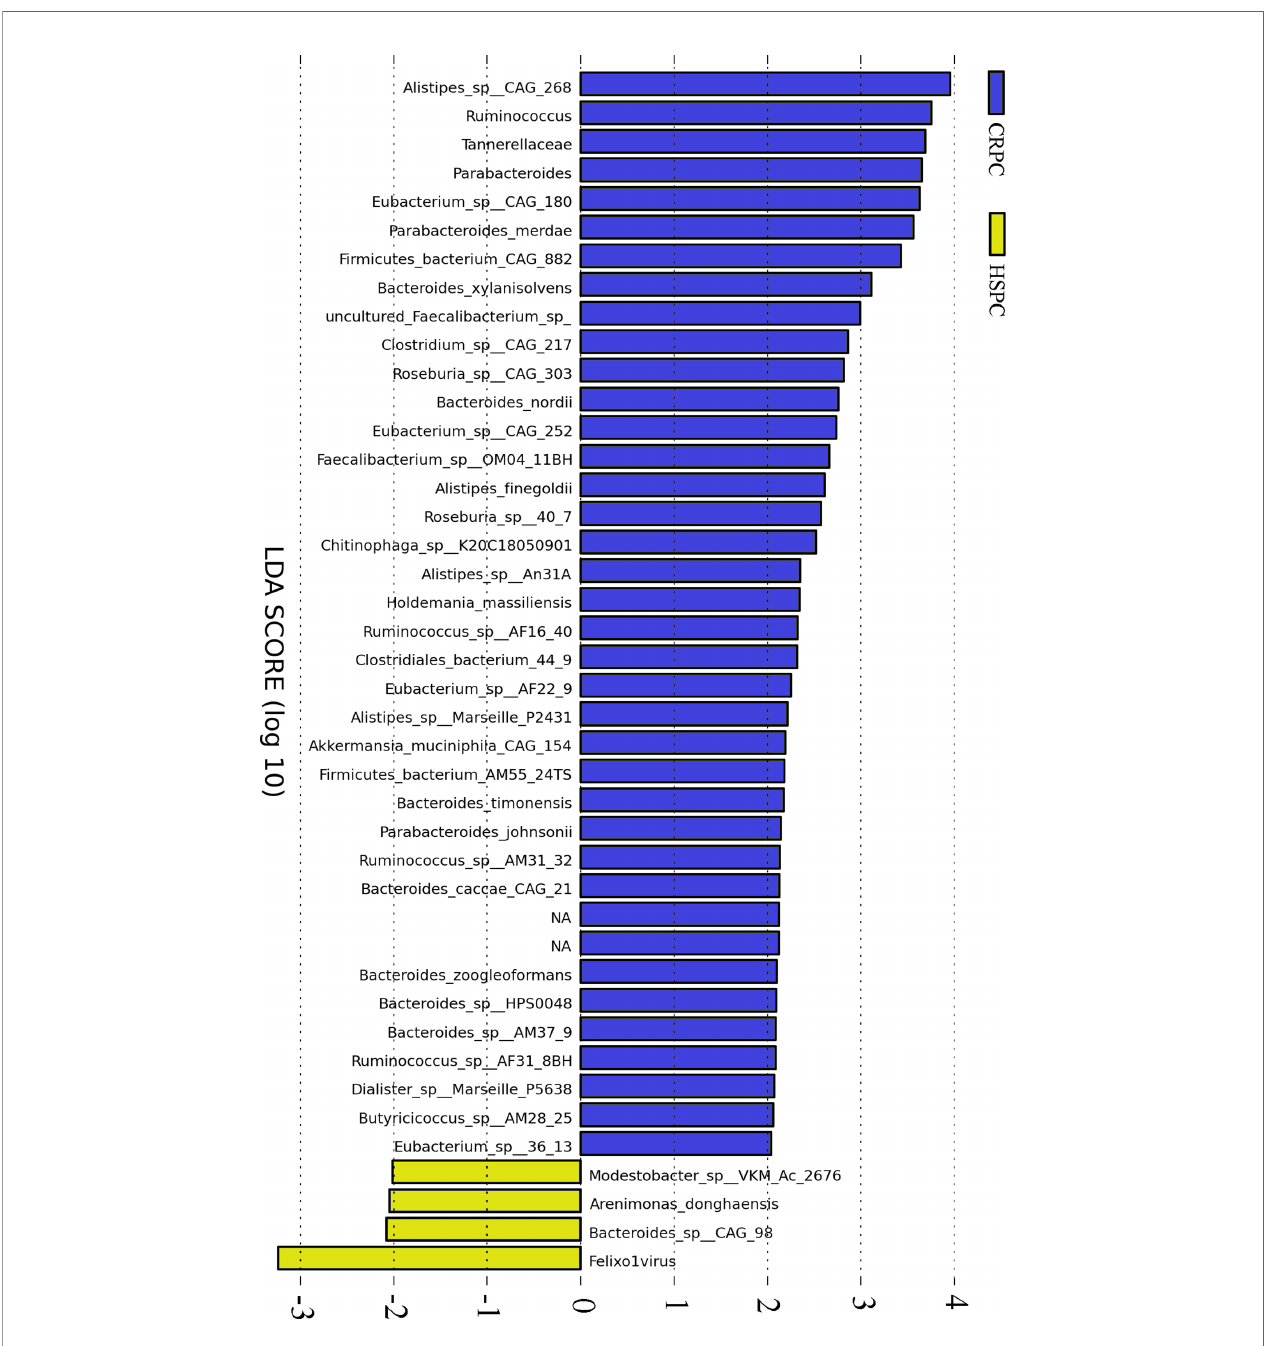
FIGURE 2 | Differentiated microbial phylotypes between CRPC and HSPC individuals. Metagenomics identi fi ed 44 differentiated microbial phylotypes between the two cohorts with LEfSe analysis (LDA>2, P <0.05), Ruminococcus and three subordinate species were more abundant in CRPC